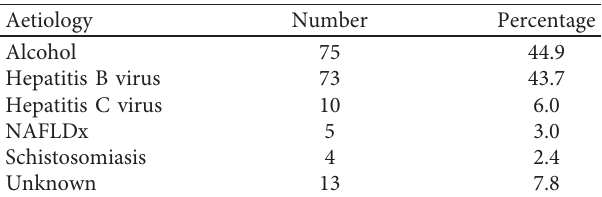
Table 3: Causes of liver cirrhosis.